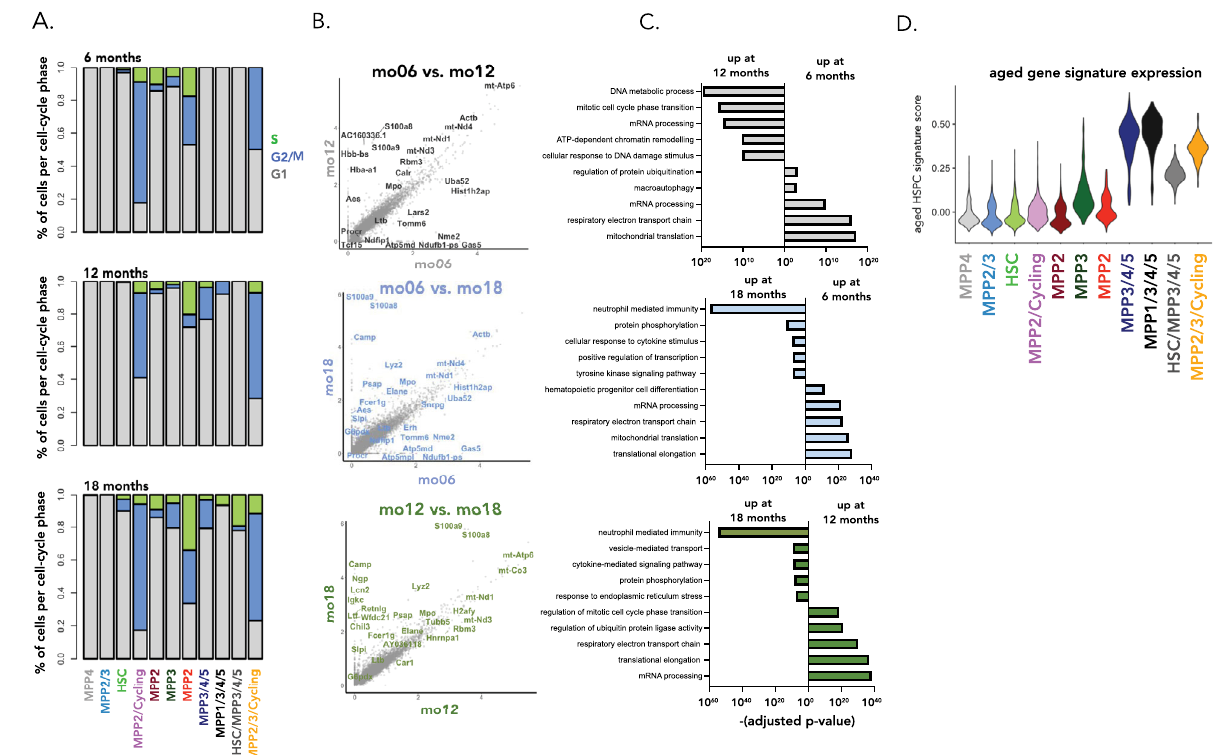
Fig. 6 | Transcriptomic differences between young and aged HSPCs. A Proportionofcells per cell cycle phase,percluster,and age. Cellswereclassi fi ed into G1/G2 + M/S phases of the cell cycle using a classi fi er approach 44 . B DifferentiallyexpressedgenesbetweenHSPCsfrommaleDRAGmiceaged6.5,12, and 19 months. Differential expression analysis was performed using a logistic regressiontestasimplementedintheSeuratRpackage.Bonferronicorrectionwas applied to correct for multiple testing C Pathways enriched in HSPCs at different ages.PathwayanalysiswasperformedusingtheenrichRRpackageusingavariation of Fisher ’ s exact test (two-sided), which also considers the size of each gene set